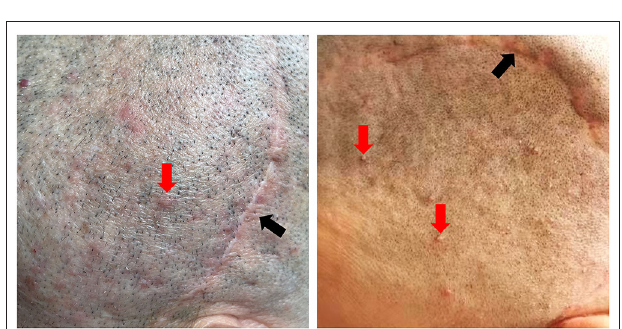
FIGURE 6 | Patient’s appearance of unfavorable preoperative scar and scalp. Red arrow: folliculitis around the surgical area; black arrow: irritated scar. (Consent for publication has taken from